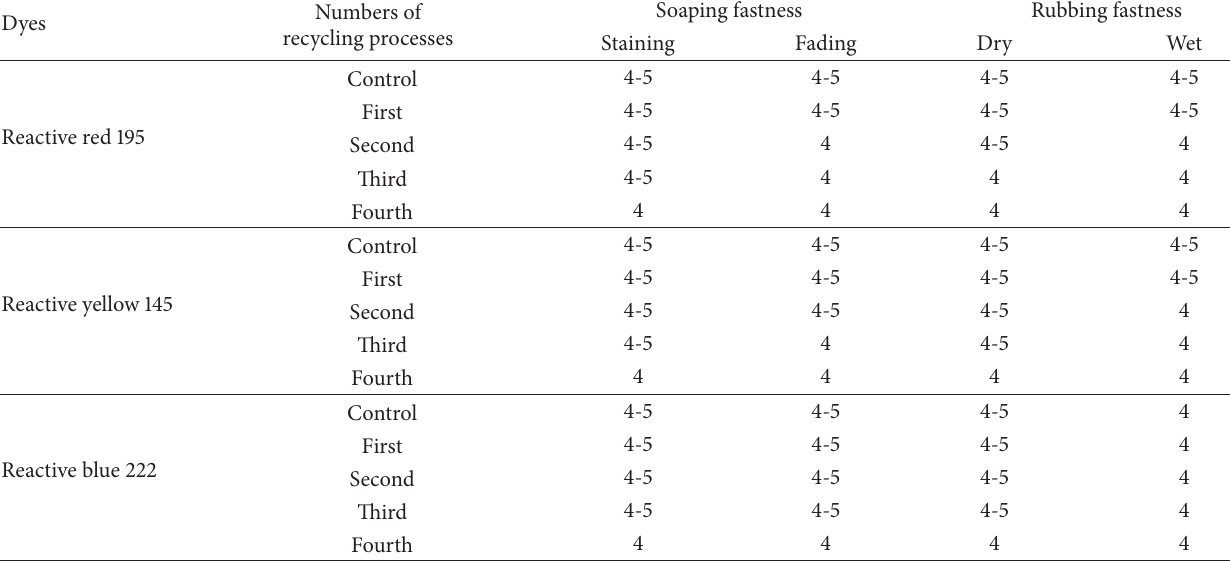
Table 5: Soaping and rubbing fastness of dyed cotton fabrics in recycling processes.